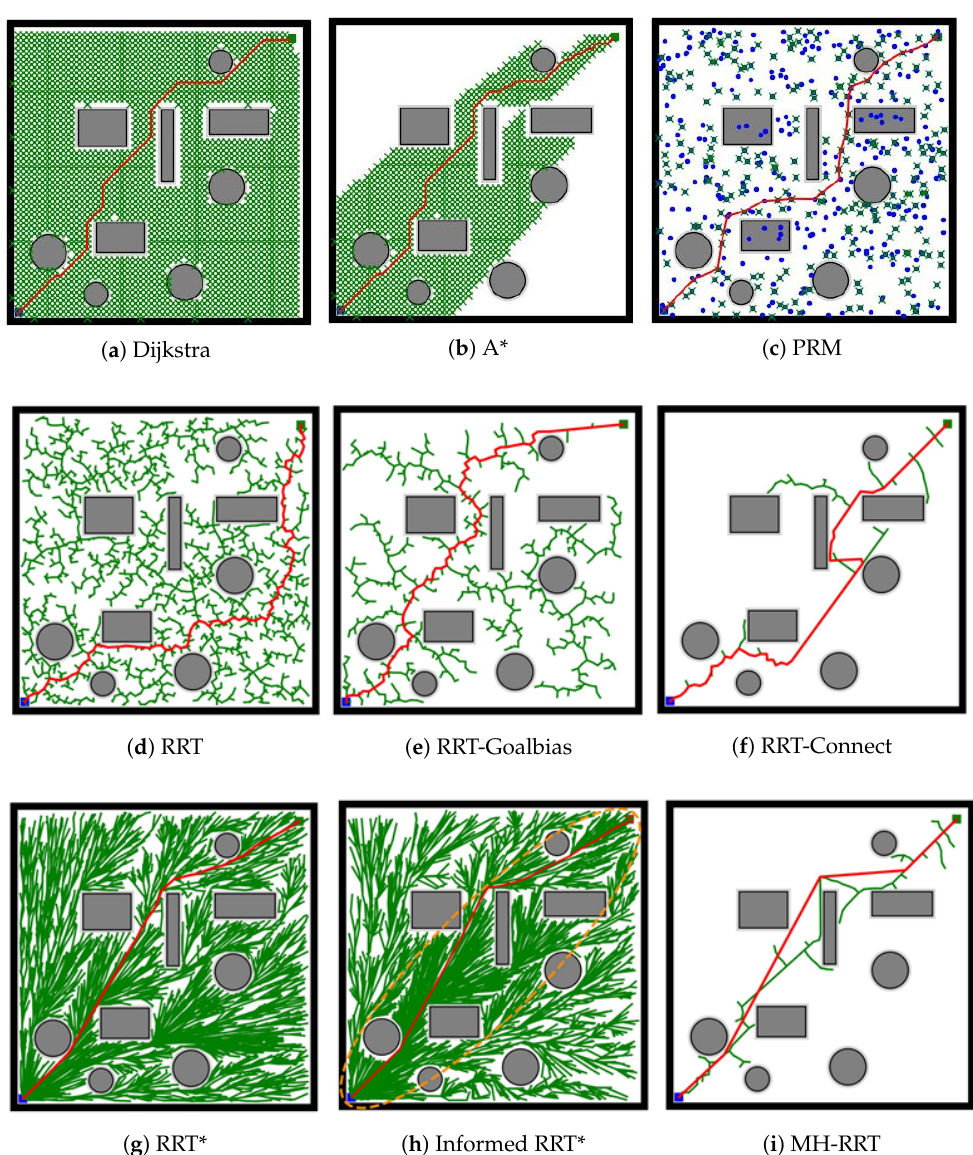
Figure 10. Illustration of nine global path planning results in map Dense. In ( a , b ), the green grids indicate that these grids have been searched. In ( c ), the green crosses indicate that these points have been sampled. In ( d – i ), the green curves denote the state tree structure. In all subfigures, the red line means the final path. All experiments start from the bottom left (marked in blue), and end at the top right (marked in